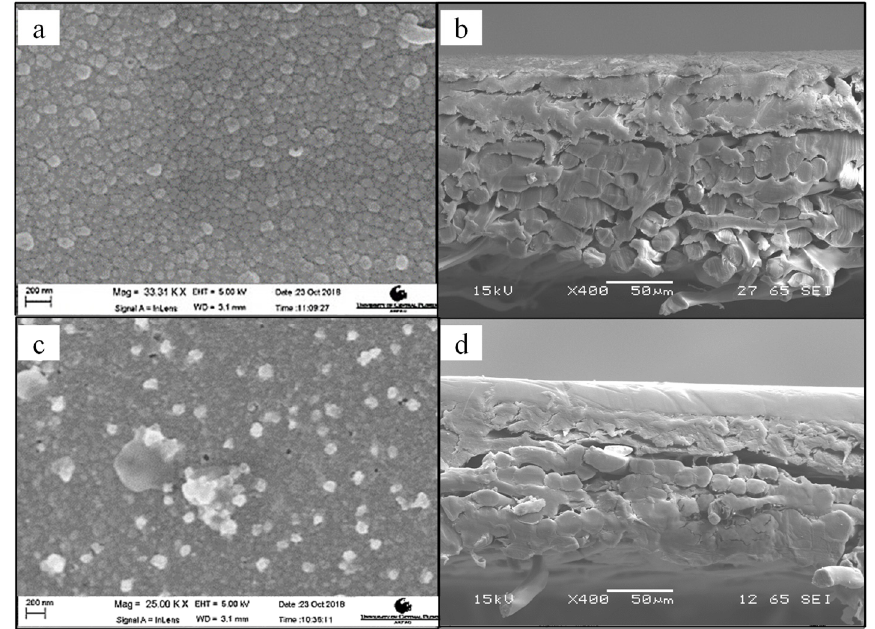
Figure 4. SEM images of a virgin membrane surface ( a ) and cross-section ( b ); 5 PAH/PAA BL-assisted AgPNP-immobilized UF membrane surface ( c ) and cross-section ( d ).